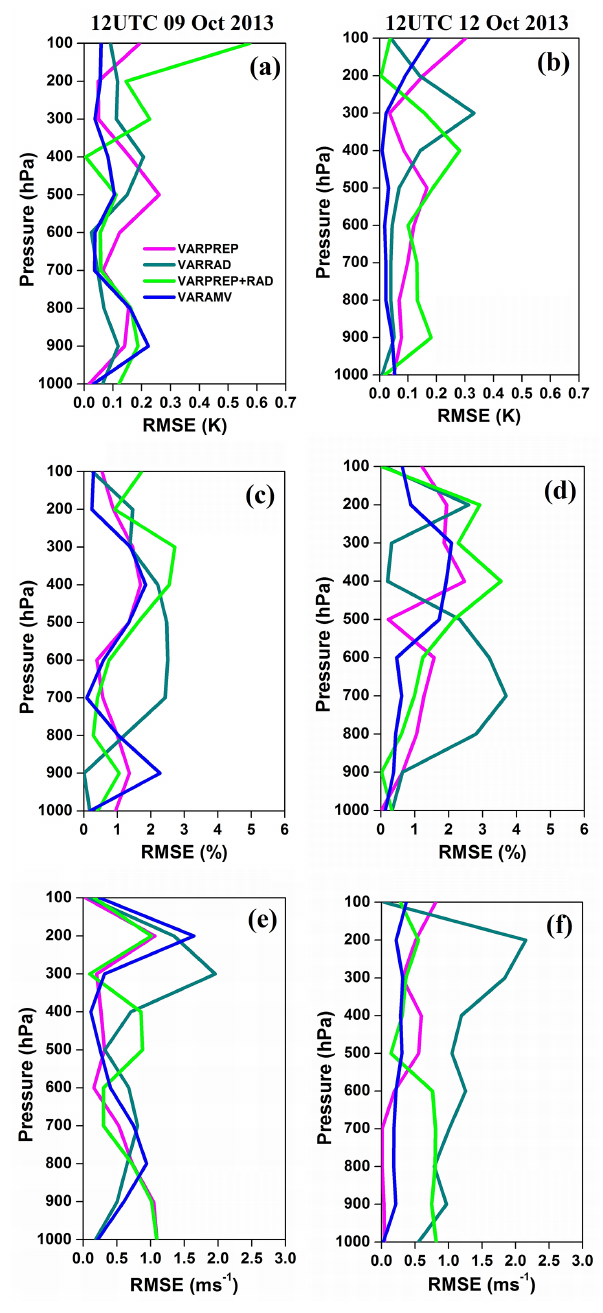
Figure 8. Vertical profile of domain-averaged RMSE for (a, b) tem- perature (K), (c, d) relative humidity (%) and (e, f) wind speed (ms − 1 ) relative to CTL. The left panels (a, c, e) are differences at initial time for 12:00UTC 9 October and right panels (b, d, f) are differences for 3-day forecasts for 12:00UTC 12